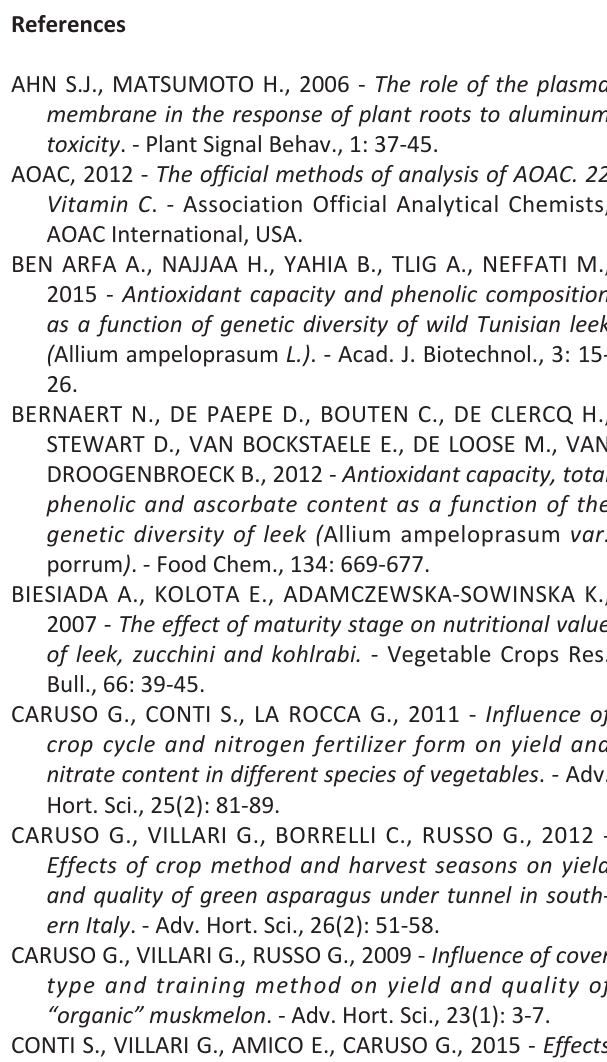
Table 6 - Correlation coefficients between mineral elements in A. porrum pseudo-stems P≤0.05.As Ca